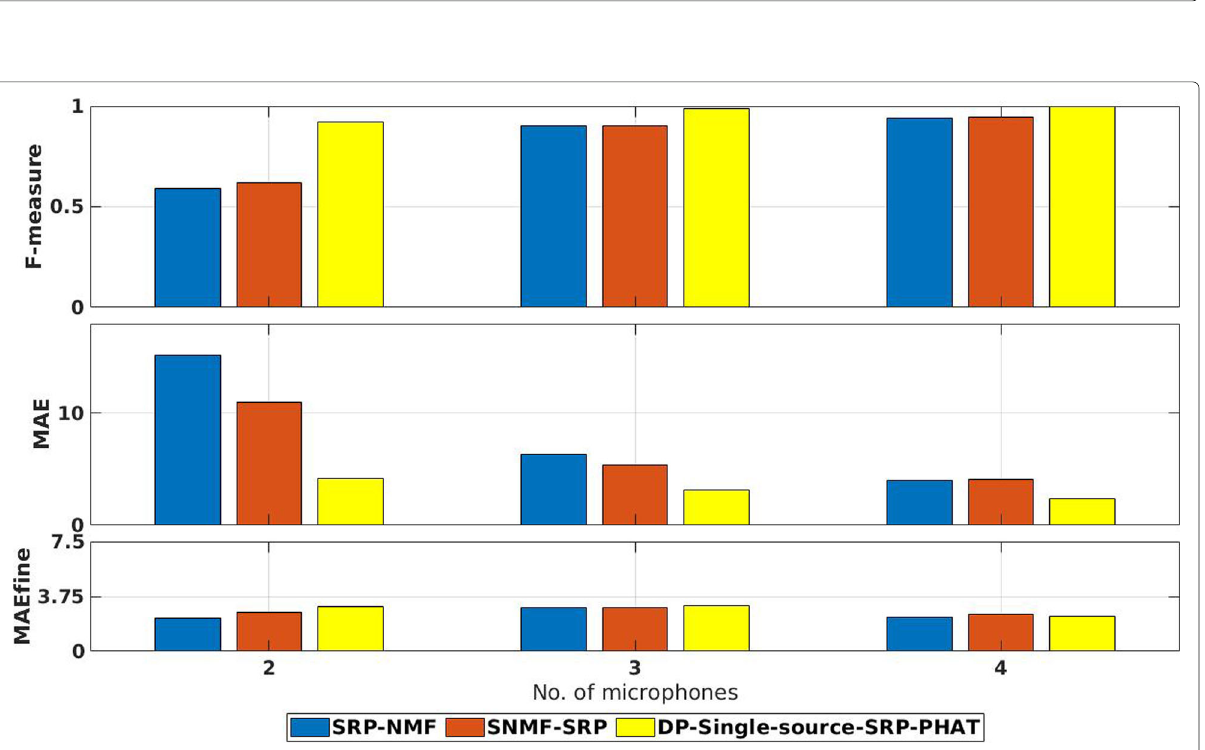
Fig. 7 Performance comparison of SNMF-SRP, DP-single-source-SRP-PHAT, and the proposed SRP-NMF in terms of the chosen instrumental metrics on the AACHEN dataset, on various subsets of the 8-microphone uniform linear array with an inter-microphone spacing of 8cm